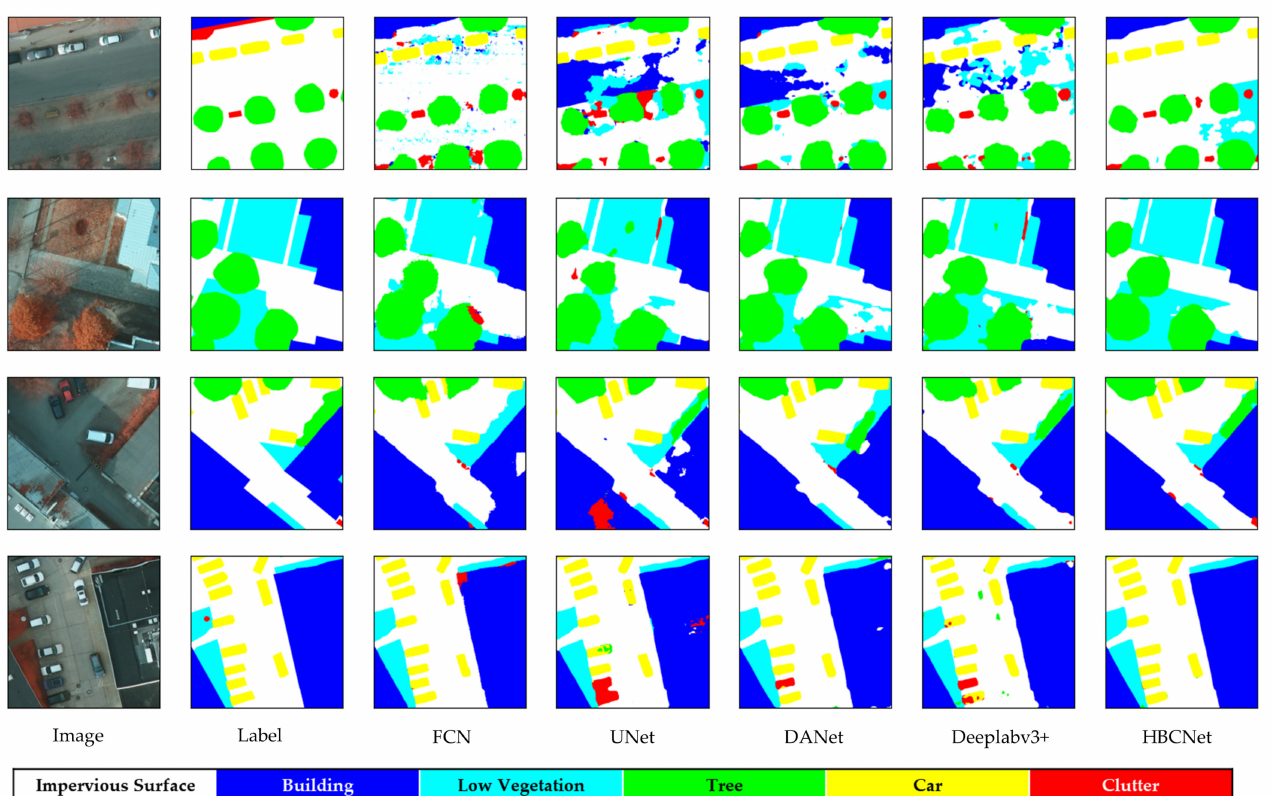
Figure 7. Qualitative comparisons between our method and other models for the Potsdam test dataset. (From left to right ) Columns demonstrate the original images, the image ground truth, the predictions of FCN, UNet, DANet, Deeplabv3+, and the predictions of